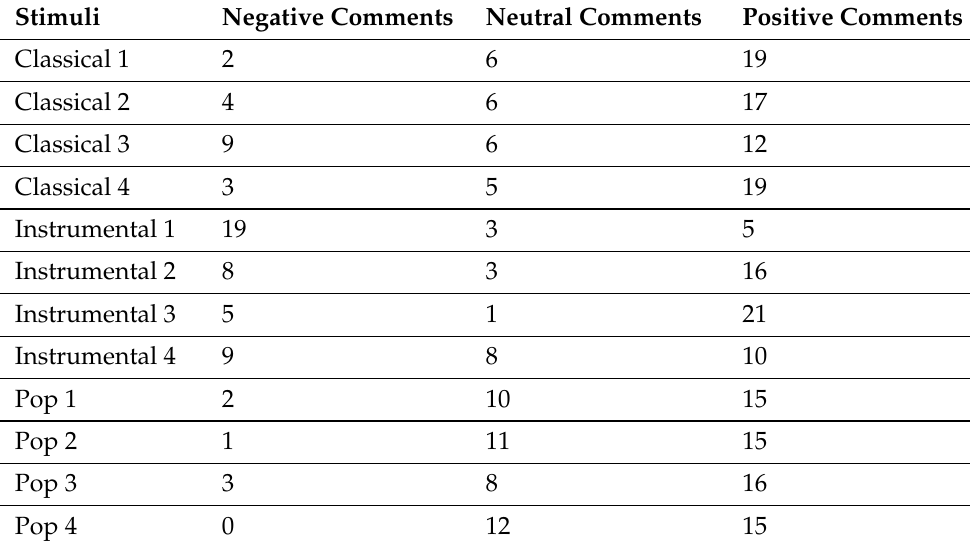
Table 4. Kinds of Comments Provided by Participants on Each Music